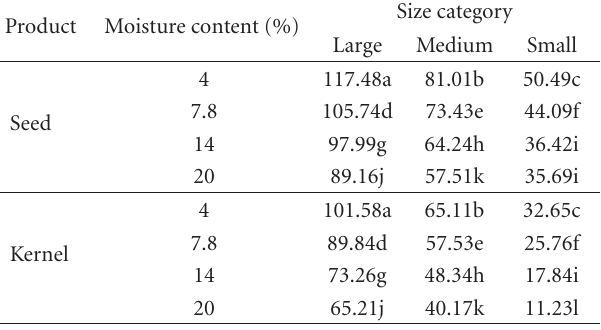
Table 2: Mean comparison of elastic modulus (Mpa) of pumpkin seed and its kernel considering interaction e ff ect of moisture con- tent and